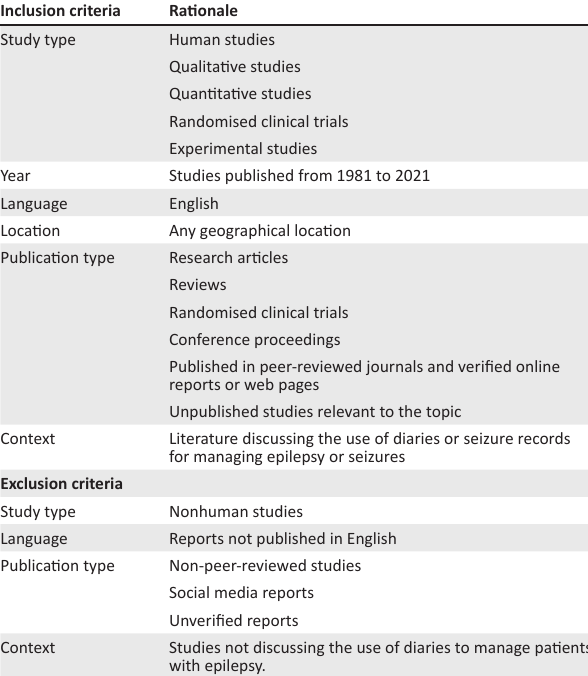
TABLE 1: Inclusion and exclusion criteria. Inclusion criteria